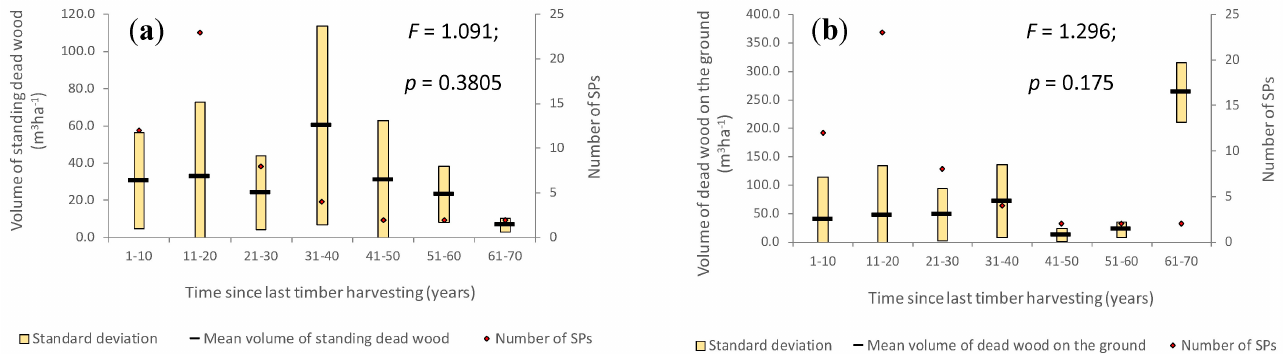
Figure 7. Volume of standing dead wood ( a ) and volume of dead wood on the ground ( b ) against time classes since last timber harvesting.